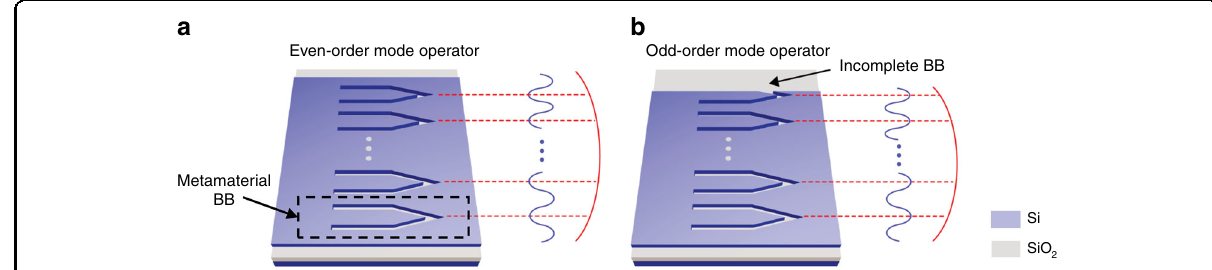
Fig. 1 3D schematics for the mode operators. 3D schematics for the even-order ( a ) and odd-order ( b ) mode operators, respectively. The dashed box in ( a ) denotes a metamaterial BB. Reproduced from ref. 12, by permission from Springer Nature, Light: Science &